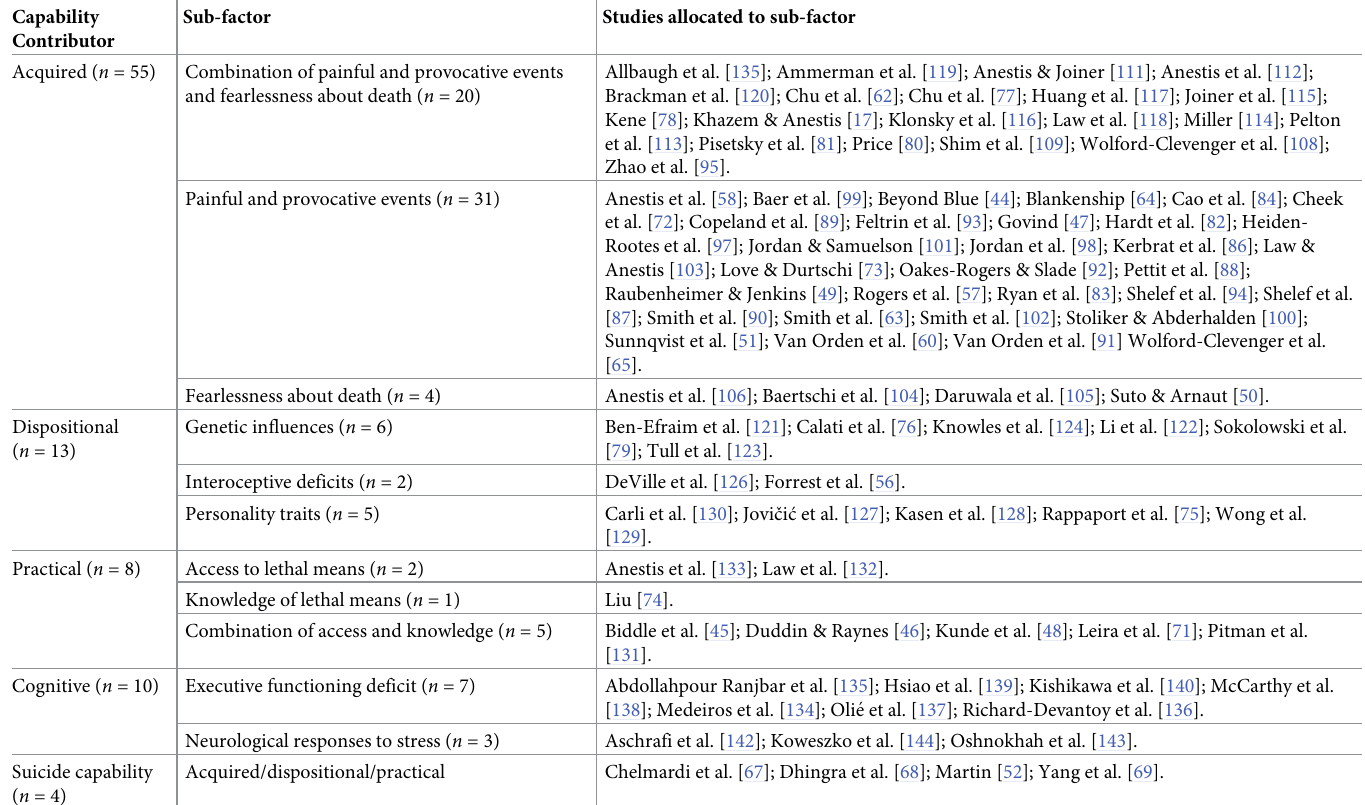
Table 5. Study sub-factor